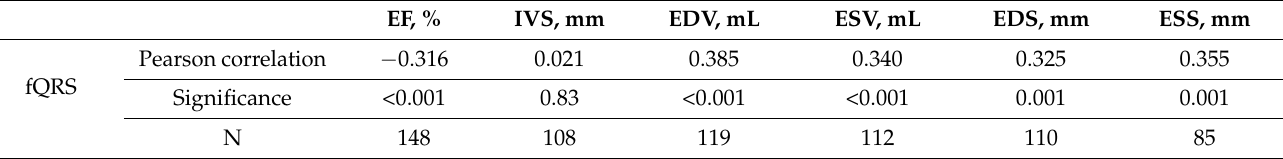
Table 2. Correlations between indices of the myocardial systolic function and fQRS.